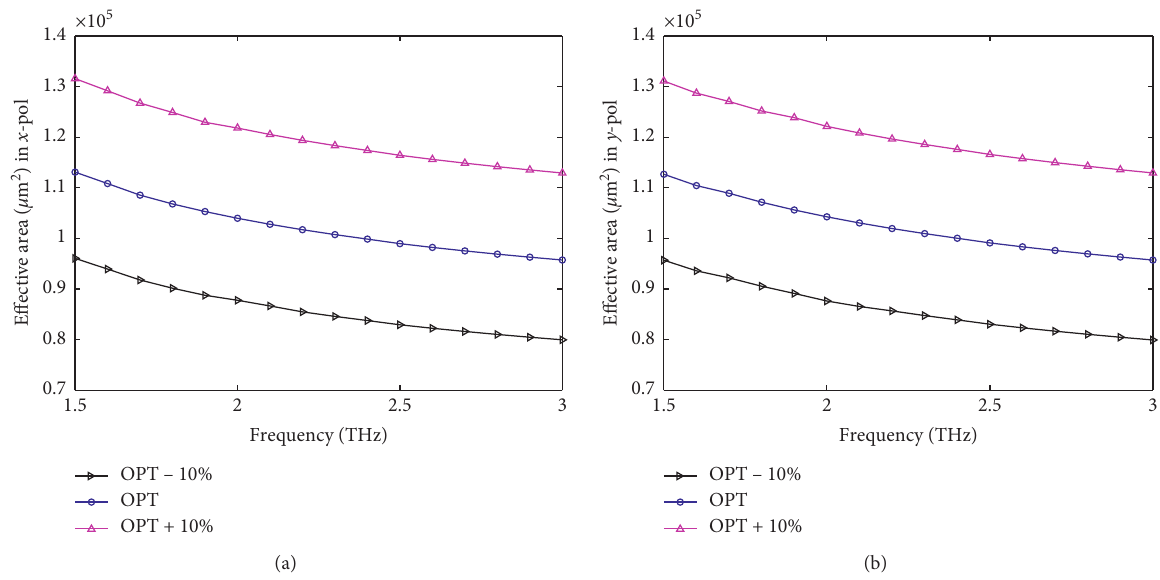
Figure 3: Comparison of the EAs for the three models in the THz band. (a) x -PoM and (b) y -PoM.